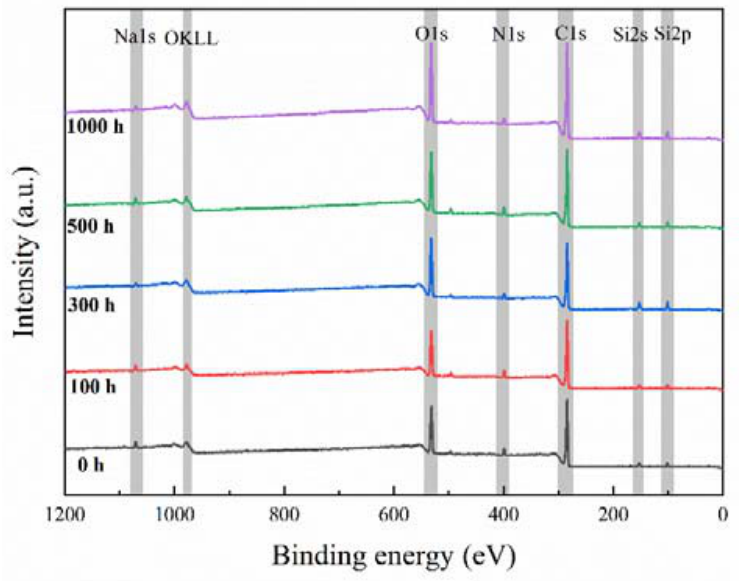
Figure 9. XPS full scan spectra of Kevlar fibers before and after ozone exposure at different time. Table 2. Relative content of elements before and after ozone